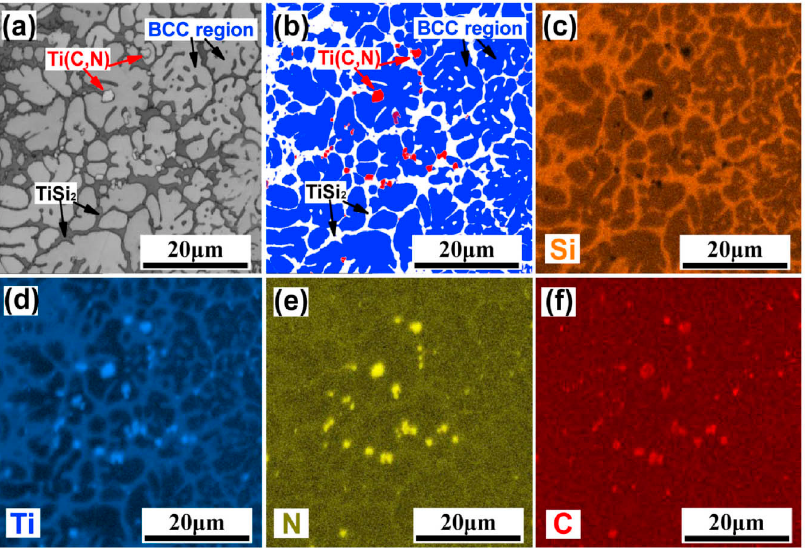
Figure 21. The microstructures with EBSD and EDS results of in the zone I (see Figure 12), ( a ) EBSD band contrast (BC) map, ( b ) EBSD phase map, ( c – f ) EDS element distribution maps for Si, Ti, N and C. Reprinted with permission from Ref. [95]. Copyright 2021 Elsevier.